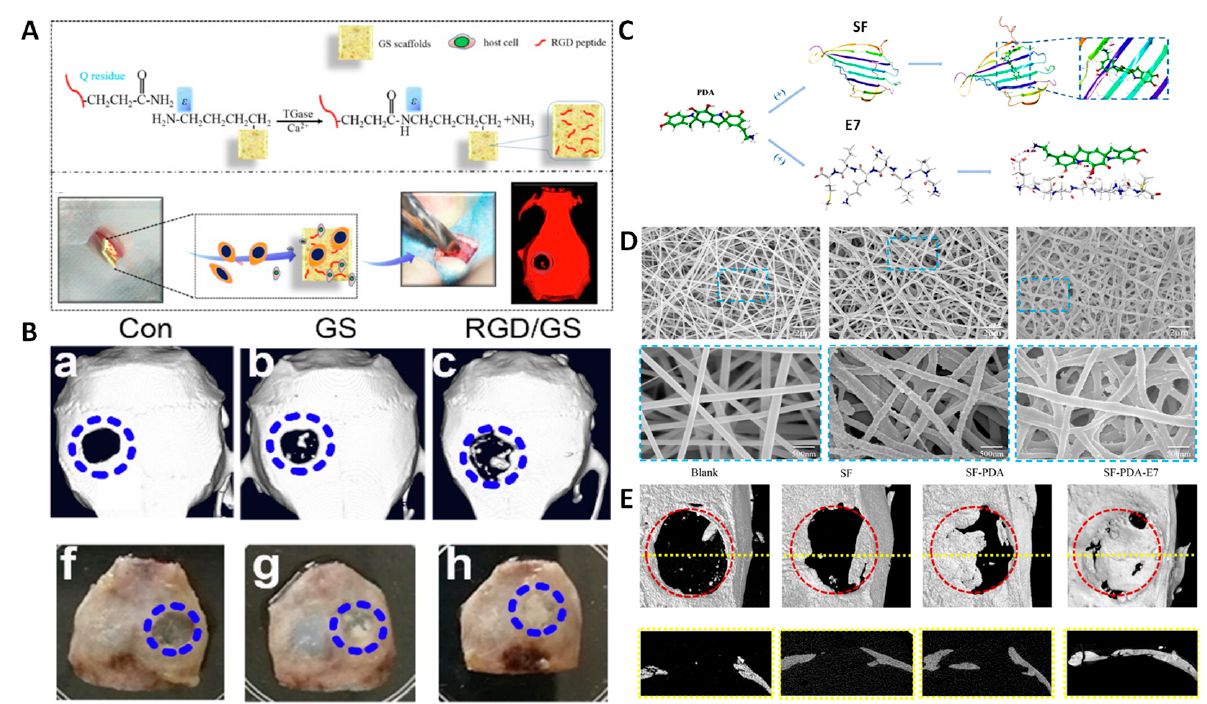
Figure 8. Example of systems employing the most-common peptides for bone regeneration. Left: RGD. ( A ) Fabrication scheme. ( B ) µCT images of the repaired calvarian bone after 12 weeks. Right: E7. ( C ) Preparation scheme. ( D ) Electrospun fiber morphology of different groups. ( E ) Magnetic resonance imaging (MRI) and µCT images of the repaired calvarian bone after 8 weeks. Adapted with permission from [131] (Elsevier) and [136] (ACS Publications).